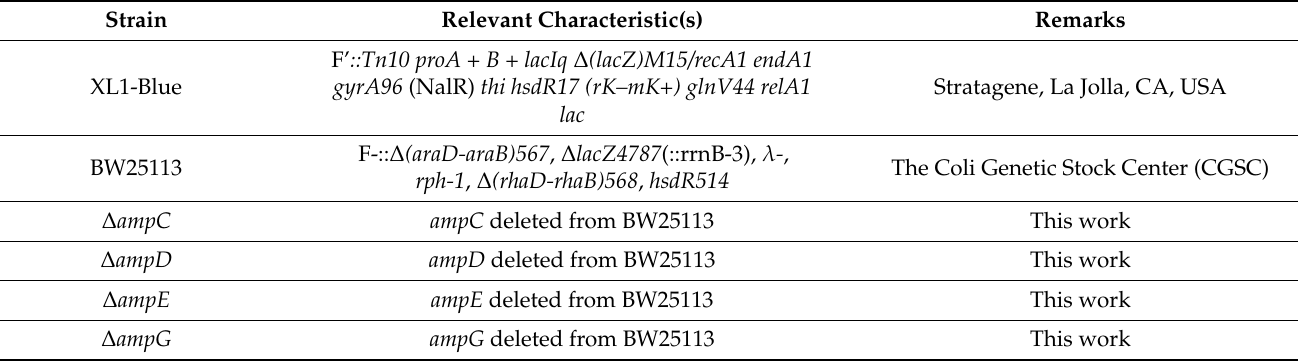
Table 3. Strains and plasmids used in this study.